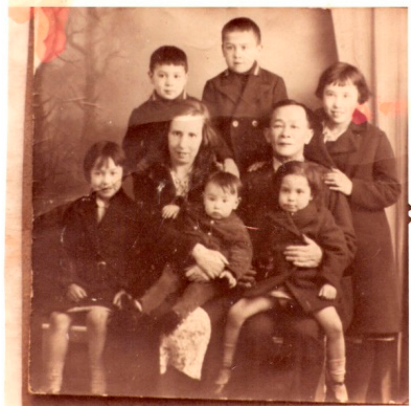
Figure 12. The wedding party of Mohammed Hassan, a Somalian man, and Katie Link, a mixed-race Welsh woman, in Butetown, c. 1925. Image courtesy of Butetown History & Arts Centre.